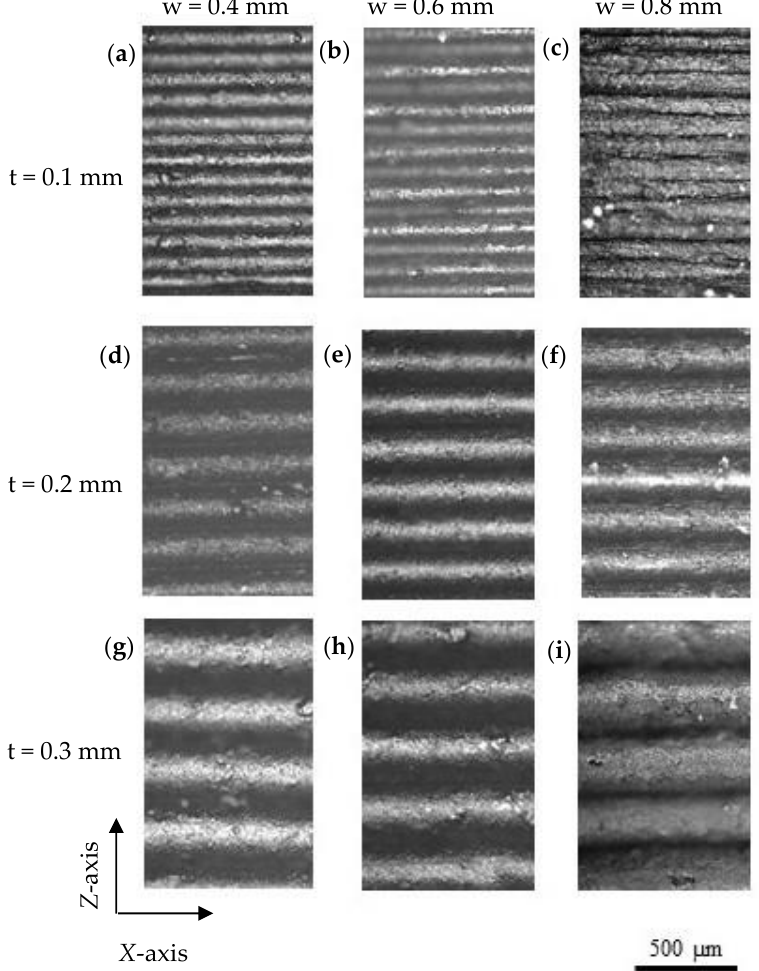
Figure 6. Optical micrographs of the layers thickness of 3D printed parts: ( a ) P1.4, ( b ) P1.6, ( c ) P1.8, ( d ) P2.4, ( e ) P2.6, ( f ) P2.8, ( g ) P3.4, ( h ) P3.6 and ( i ) P3.8 (t = layer thickness, w = extrusion width).